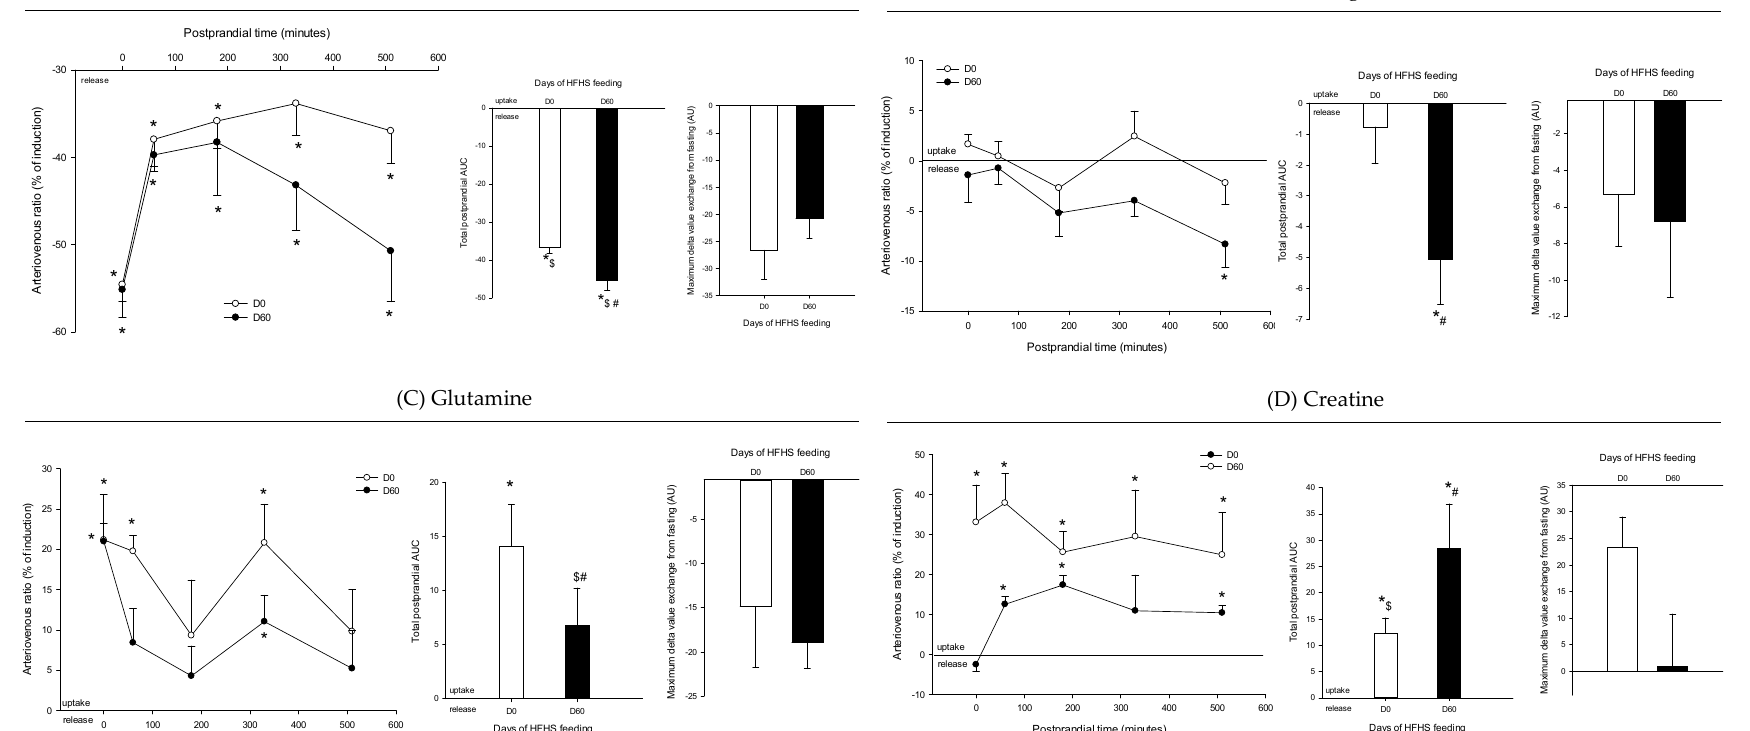
Figure 8. Arteriovenous fold change (A/V) of ( A ) acetate, ( B ) gluconeogenic amino acids, ( C ) glutamine, and ( D ) creatine across the intestine on five Yucatan mini-pigs submitted to a HFHS diet during two months. Data is presented in % of induction (mean + sem) and the exchange was analyzed using a repeated-measures t -student test. *, significantly different from 0 (equilibrium), p < 0.05. For the A/V ratios and total postprandial AUC, positive values = taken up by the organ; negative values = released by the organ. #, significantly different from D0, p < 0.05; $, significantly different from the fasting condition, p < 0.05. The maximum delta value exchange from fasting is also presented: the positive and negative values represent an increase or decrease exchange following the meal respectively.